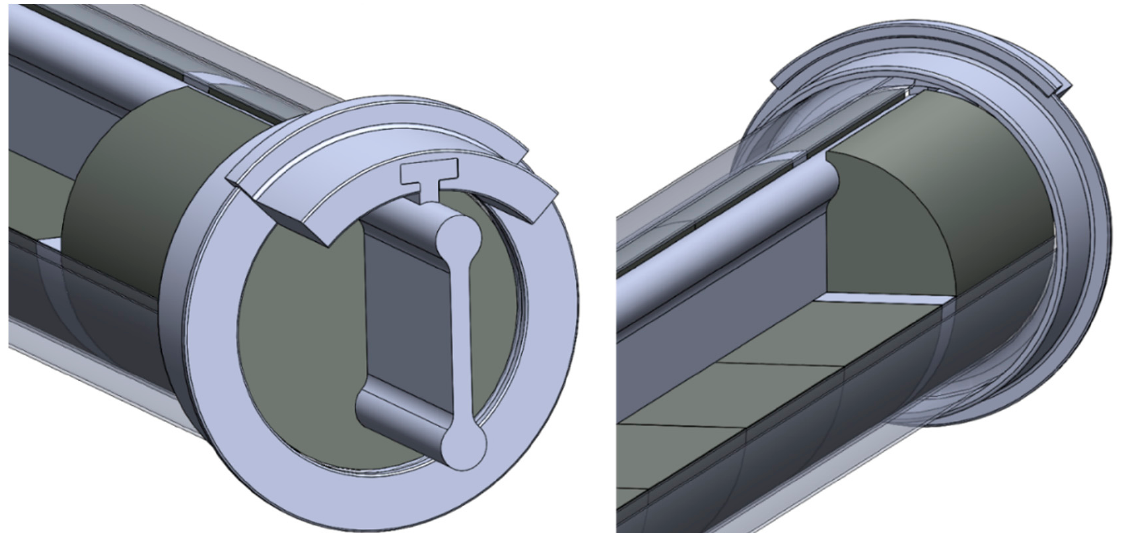
themselves, and not the inner surface of the glass tube as is the case with conventional Figure 2. Detailed view of the 3D model of the supporting system of the heat accumulators. Figure 2. Detailed view of the 3D model of the supporting system of the heat tive that the vacuum tube of a transparent heating chamber allows for a visual inspection Due to the technical and operational properties of the vacuum tube, it is advanta- geous that the concentrated solar heater of segmental heat accumulators can also be used to store heat accumulators in a charged state for their later use (for the time without suf- ficient solar radiation). Another advantageous fact is that the absorption surface where